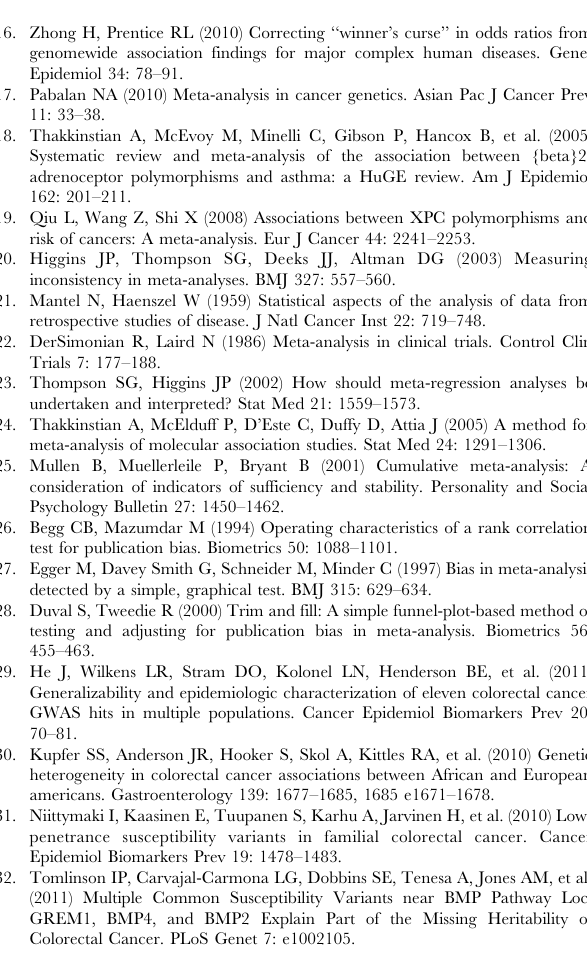
Figure S1 Flow chart for study selection. (TIF) Figure S2 Pooled frequency of the A allele in European and Asian controls. (TIF) Table S1 The characteristics of the studies included in the meta-analysis for the association of rs961253 with